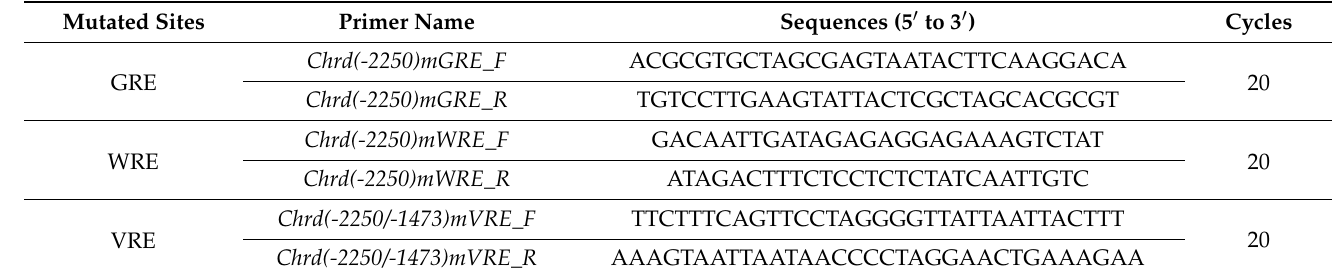
Table 3. Primers used for site-directed mutagenesis.